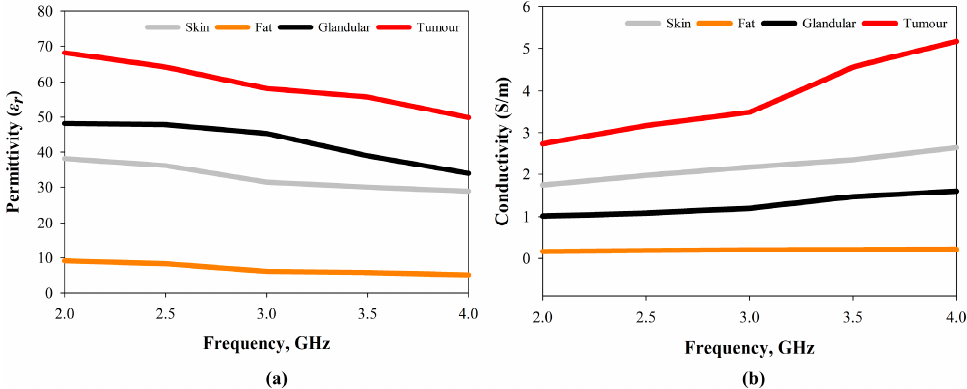
Figure 18. Dielectric properties of the fabricated heterogeneous breast phantom: ( a ) permittivity and ( b ) conductivity.